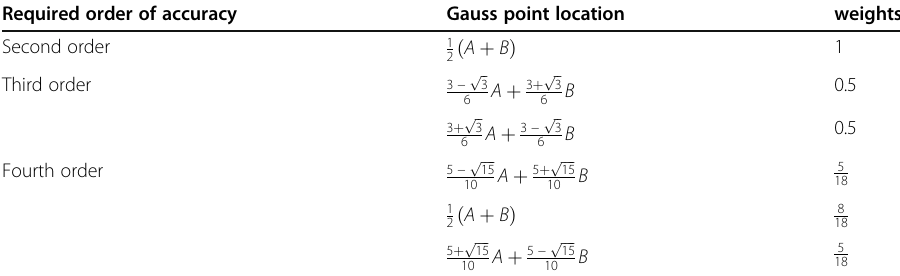
Table 9 Required order of accuracy and the gauss point location as well as the corresponding weights Required order of